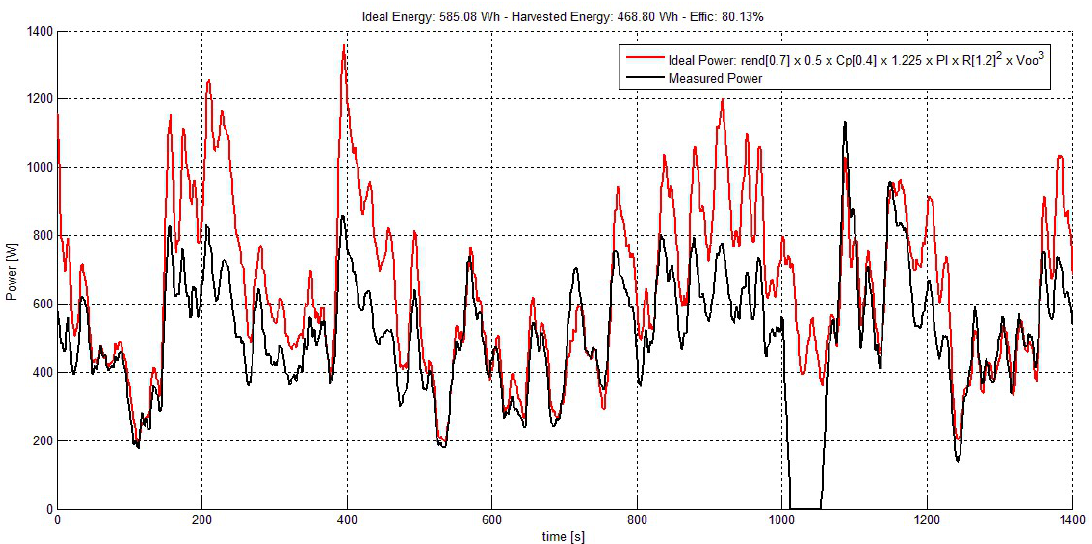
Figure 23. Energy comparison between an “ideal” system and the chopper system using the addi- tional reset functionality. tional reset functionality.